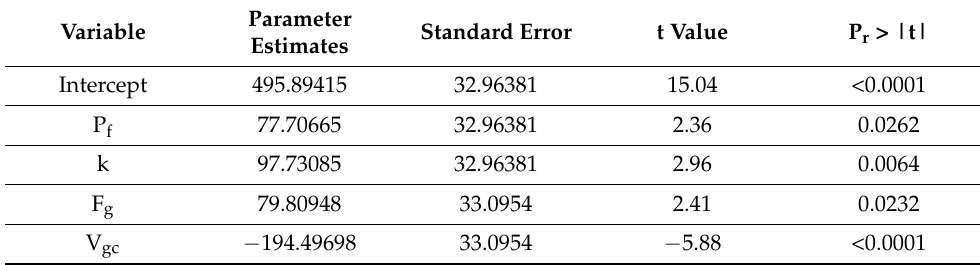
Table 3. Sensitivity analysis result for the build